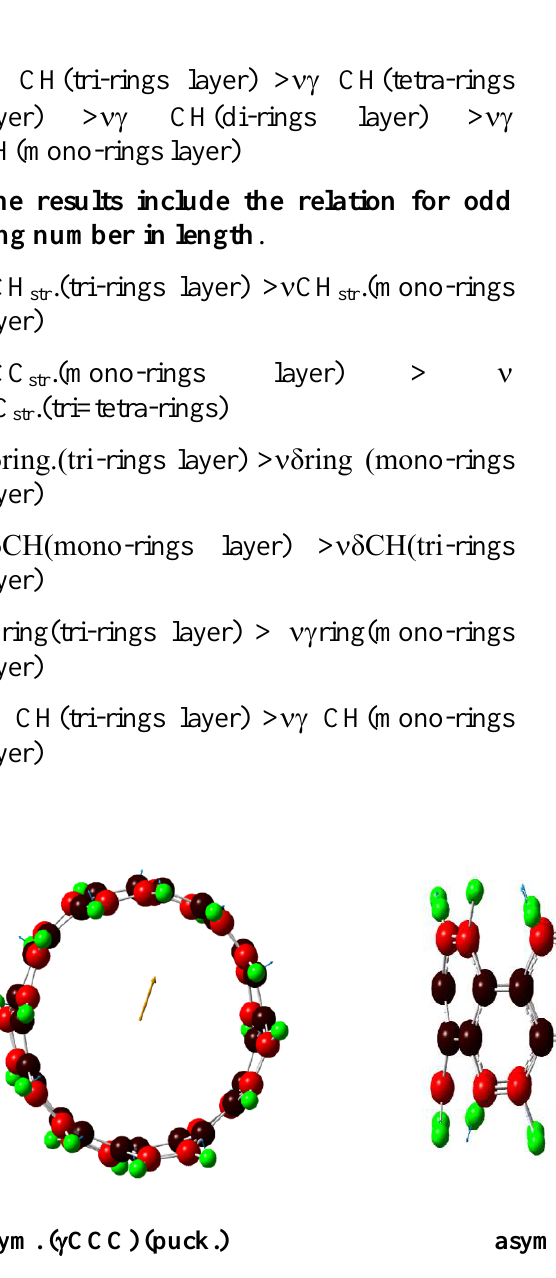
Fig.5: The graphical pictures of some vibration modes for CNT (armchair) as calculated applying G03